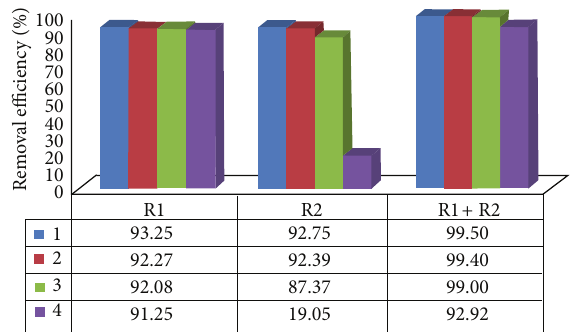
Figure 5: Removal efficiency of total coliforms in treatment system II, consisting of UASB reactor, anaerobic filter (AF), trickling filter (TF), and decanter (D) placed in series, in assays 1, 2, 3, and 4.